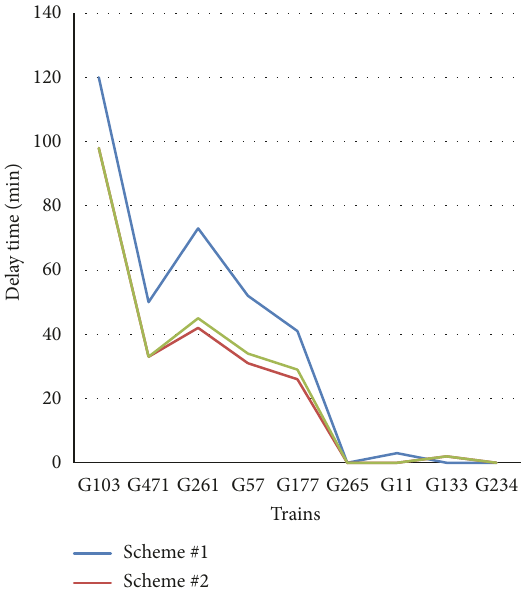
Figure 14: The delay time of each train in different delay